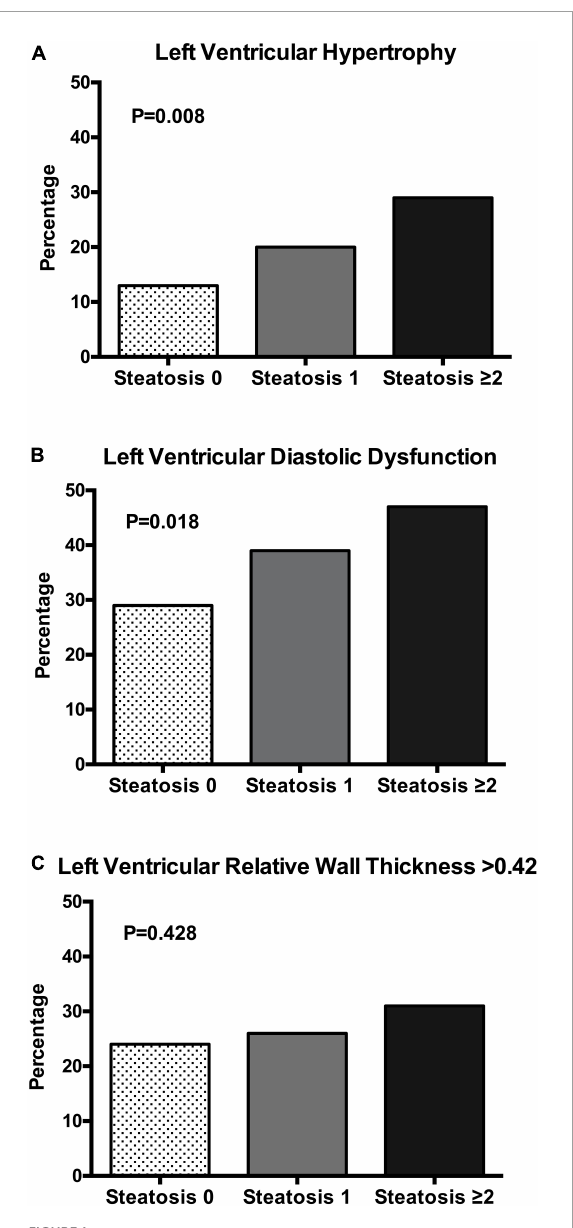
FIGURE1 Bar graph showing the prevalence of left ventricular hypertrophy (A) , left ventricular diastolic dysfunction (B) , and left ventricular relative wall thickness (C) in patients with essential hypertension according to the number of liver steatosis scores (none, 1, ≥ 2). The chi square test was used to compare the frequency in the three